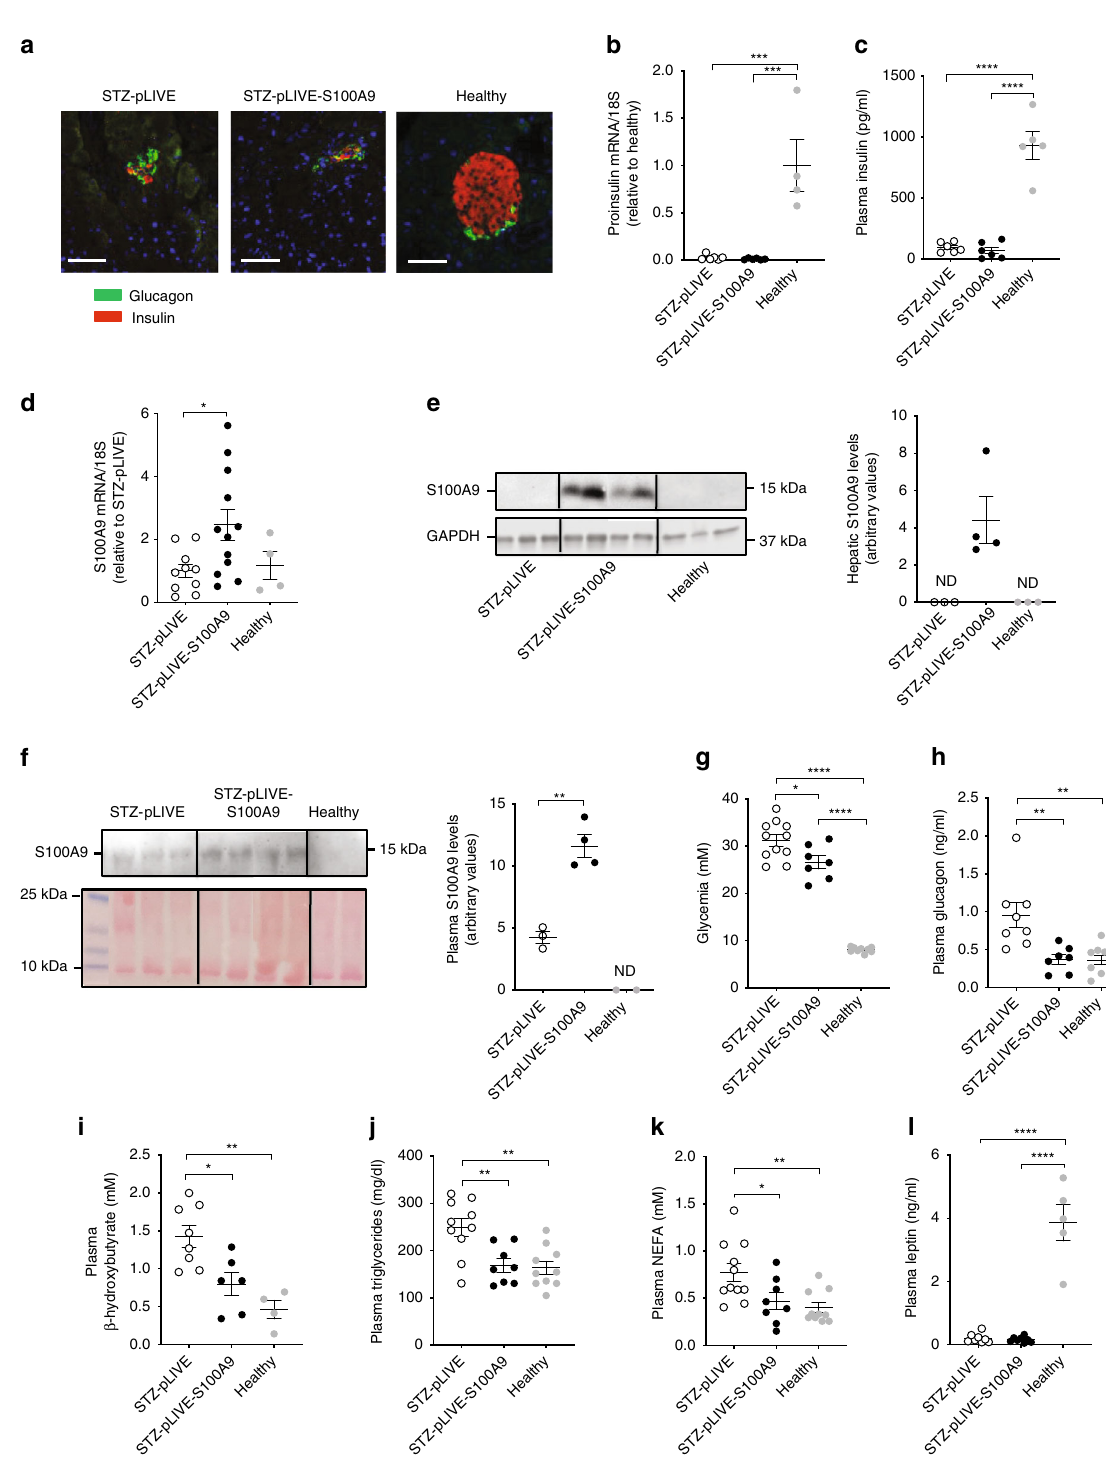
Fig. 2 S100A9 ameliorates metabolic imbalance in STZ-induced ID mice. a Immunohistochemistry of pancreatic islets showing insulin (red) and glucagon (green) in STZ-treated mice (sacri fi ced 10 days after HTVI) and their age-matched non-diabetic healthy controls. Scale bar is 50 µ m. In STZ-pLIVE and STZ-pLIVE-S100A9 (10 days after HTVI), and their age-matched healthy controls : b proinsulin mRNA ( n /group = 6, 6, and 4); c Plasma insulin content ( n /group = 6, 6, and 5); d hepatic S100a9 mRNA ( n /group = 10, 12, and 4); e hepatic S100A9 levels ( n = group: 3, 4, and 3); f plasmatic S100A9 levels ( n /group = 3, 4, and 2); g glycemia ( n /group = 11, 7, and 9); h plasma glucagon levels ( n /group = 8, 7, and 10); i plasma β -hydroxybutyrate levels ( n /group = 8, 6, and 4); j plasma triglycerides levels ( n /groups = 10, 8, and 10); k plasma NEFAs levels ( n /group = 11, 8, and 10); and l plasma leptin levels ( n /group = 8, 8, and 5). Error bars represent SEM. Statistical analyses were done using one-way ANOVA (Tukey ’ s post hoc test). Of note, similar results were obtained in another cohort maintained under identical conditions. * P < 0.05; ** P < 0.01, *** P < 0.001, **** P < 0.0001. Western blot results shown in e , f are cropped images of the whole g e l. Source data are provided as a Source Data fi le